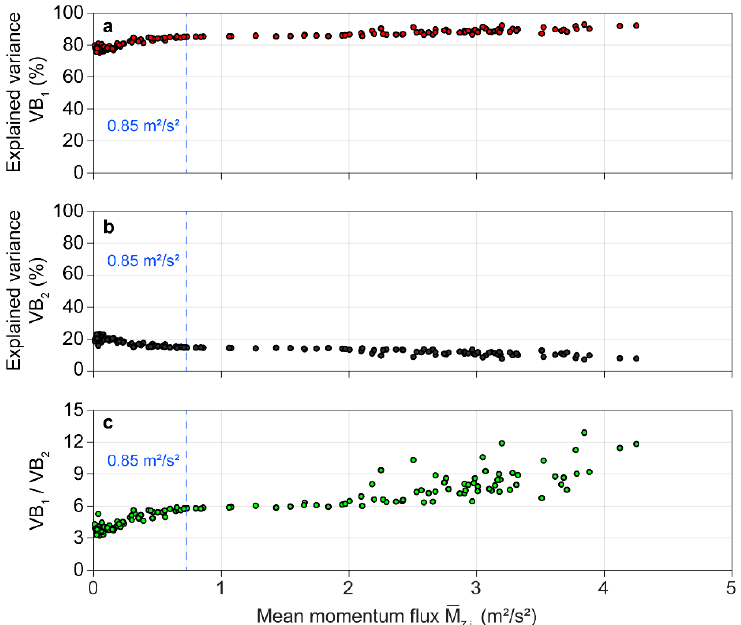
Figure 5. Explained variance associated with ( a ) the first ( 𝑉𝐵 (cid:2869) ) and ( b ) the second ( 𝑉𝐵 (cid:2870) ) bi-orthogonal decomposition (BOD) component resulting from wind-induced stem motion; ( c ) ratio VB 1 / VB 2 ; all as a function of mean momentum flux at canopy top ( 𝑀(cid:3365) (cid:2875),(cid:2920) ).